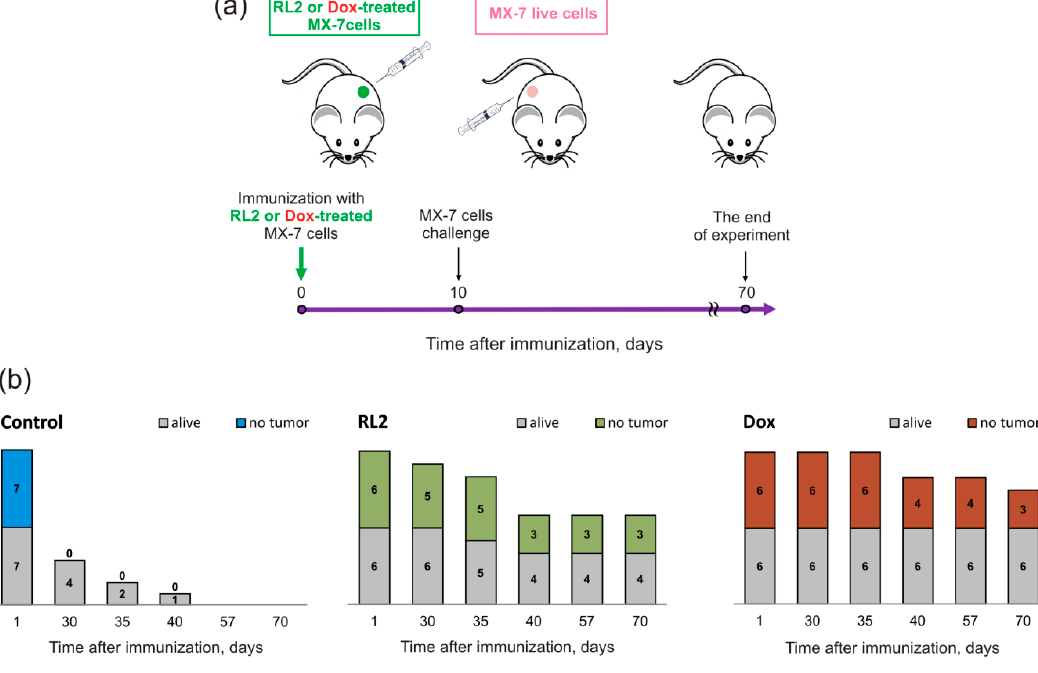
Figure 4. Immunization of C3H/He mice with MX-7 cells treated by recombinant lactaptin analog RL2. ( a ) Scheme of immunization. Syngeneic mice were s.c. immunized with RL2- or Dox-treated MX- 7 cells (7 * 10 5 cell/animal). Eight days later, the mice were challenged s.c. on the opposite flank with 7 * 10 5 live MX-7 cells. ( b ) Dynamics of live and tumor-free mice in groups. ( c ) Viability of vaccinated mice. ( d ) Dynamic of tumor growth. The differences in tumor-free mice between groups were calculated using non-parametric statistics, the Pearson ′ s chi-square test, and these were significant with p < 0.05. Kaplan–Myer survival curves and Log-Rank statistics were calculated using GraphPad Prizm Software (San Diego, CA, USA). Moreover, RL2-treated cells were more efficient in the prophylactic vaccination model than another peptide ICD inducer, RT53, which resulted in only drastically reduced tumor growth at the challenge site, with no tumor-free mice [25]. Together, our findings confirm the immunogenic properties of RL2-treated tumor cells in vivo. 2.3.2. Vaccination Supplemented with Indoleamine 2, 3-dioxygenase (IDO) Inhibitor Treatment We next studied whether the inhibition of indoleamine 2, 3-dioxygenase (IDO), the enzyme of tryptophan metabolism with immunosuppressive properties, could increase the vaccination effects of RL2-treated cells. To test our hypothesis, immunized mice were also treated with the IDO inhibitor ethyl pyruvate (EP) according to the scheme of Figure 5a. The rejection of a viable cell challenge was found in two of five mice in the RL2 group and in three of five in the RL2/EP group (Figure 5b). All mice were alive in the RL2/EP group, while in the RL2 group, one mouse died. In both experiments of vaccination, we observed dying mice in the RL2 group (Figures 4c and Figure 5c). It is likely that